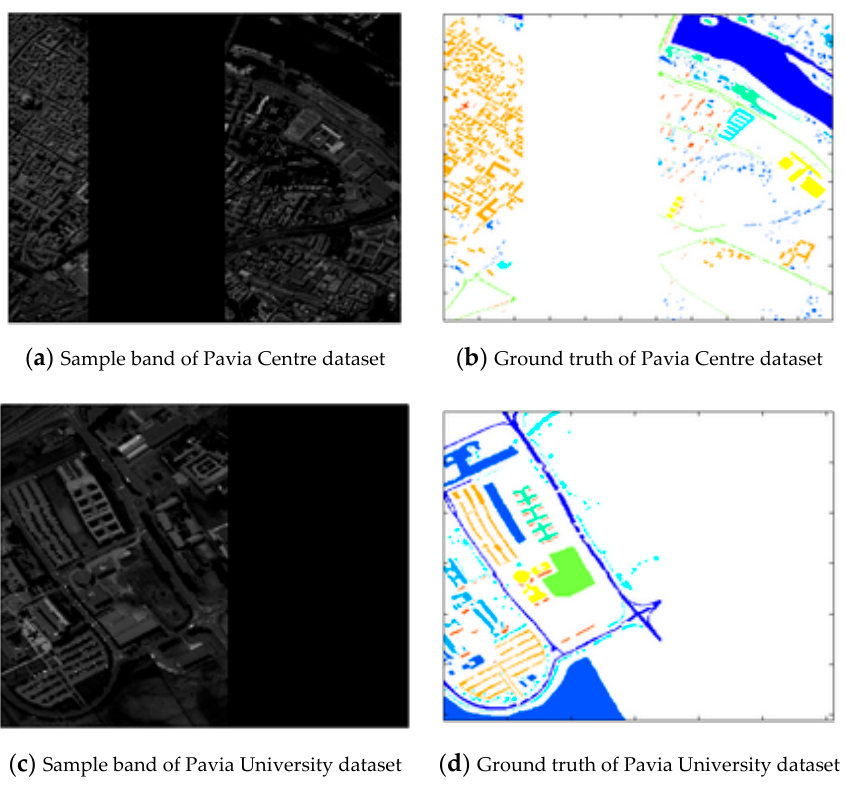
Figure 6. Noisy bands in Pavia Centre and University datasets.